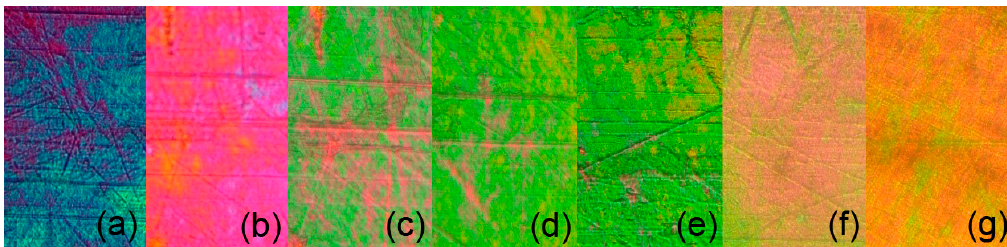
Figure 3. Optical microphotographs of PE-FLC nanocomposite obtained by POM on cooling, indicating strong change of birefringence: ( a ) the isotropic phase (Iso)-smectic A* (SmA*) phase transition at 105 °C, ( b ) the SmA* phase at 100 °C, ( c ) the SmA*-smectic C* (SmC*) phase transition at 88 °C, ( d – f ) the SmC* phase (at 86 °C, 60 °C, and 45 °C, respectively), ( g ) the Hex phase (at 40 °C). Width of each sub-microphotograph is ~300 µm.